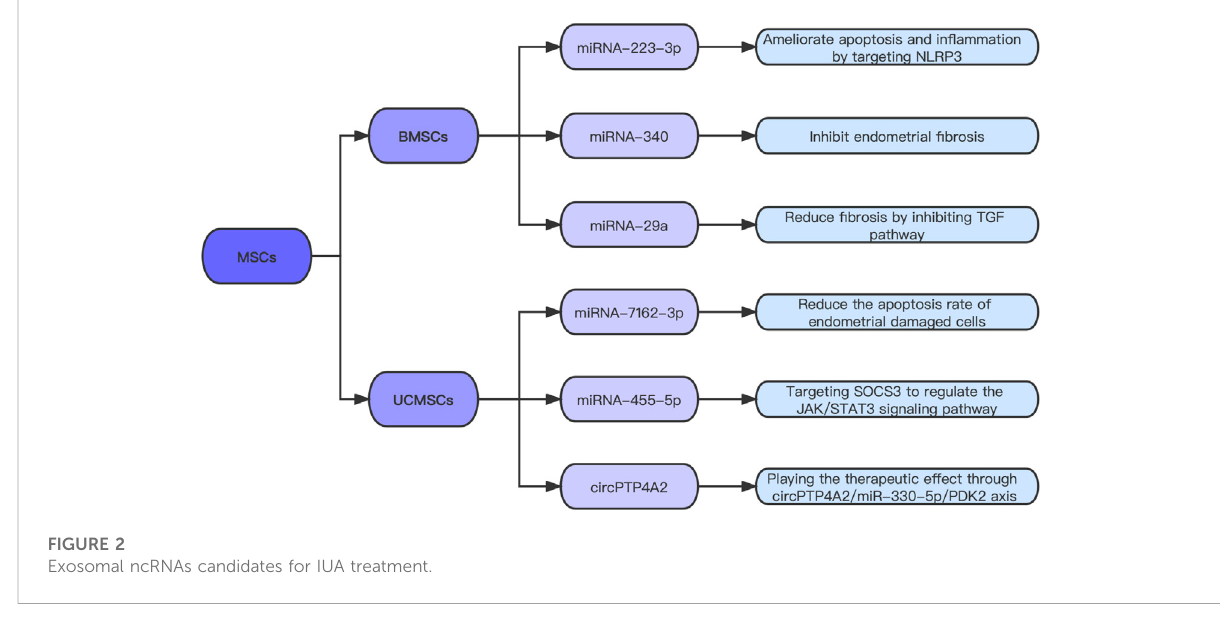
FIGURE 2 Exosomal ncRNAs candidates for IUA treatment.